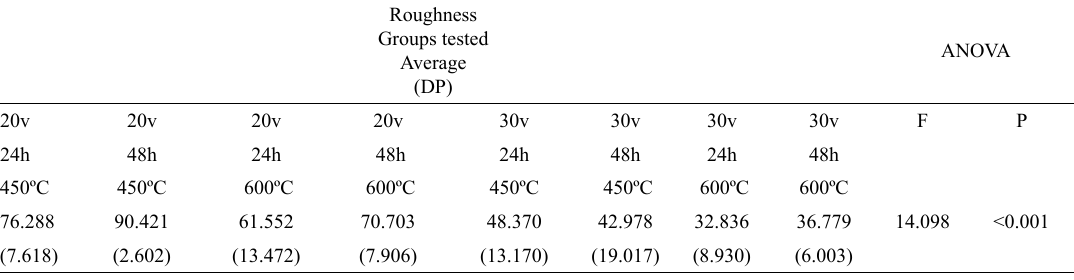
Table 2. ANOVA results complemented with Tukey. Comparison between the roughness values in the different groups